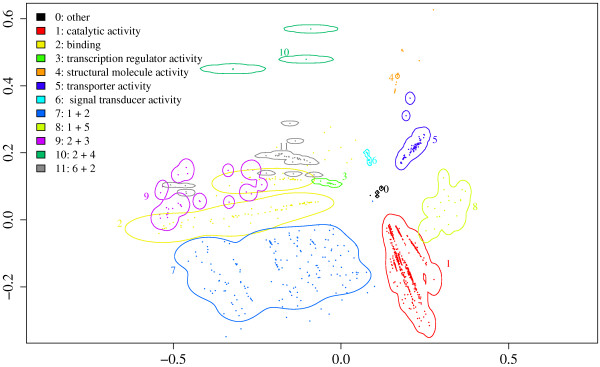
Functional map of the Pfam families. Plot of the two-dimensional multidimensional scaling of the Pfam families. The colors were chosen to resemble the molecular function annotation.